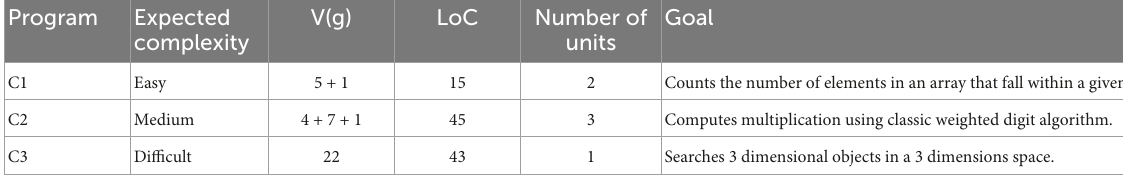
TABLE 1 Key features of the programs used in the study.